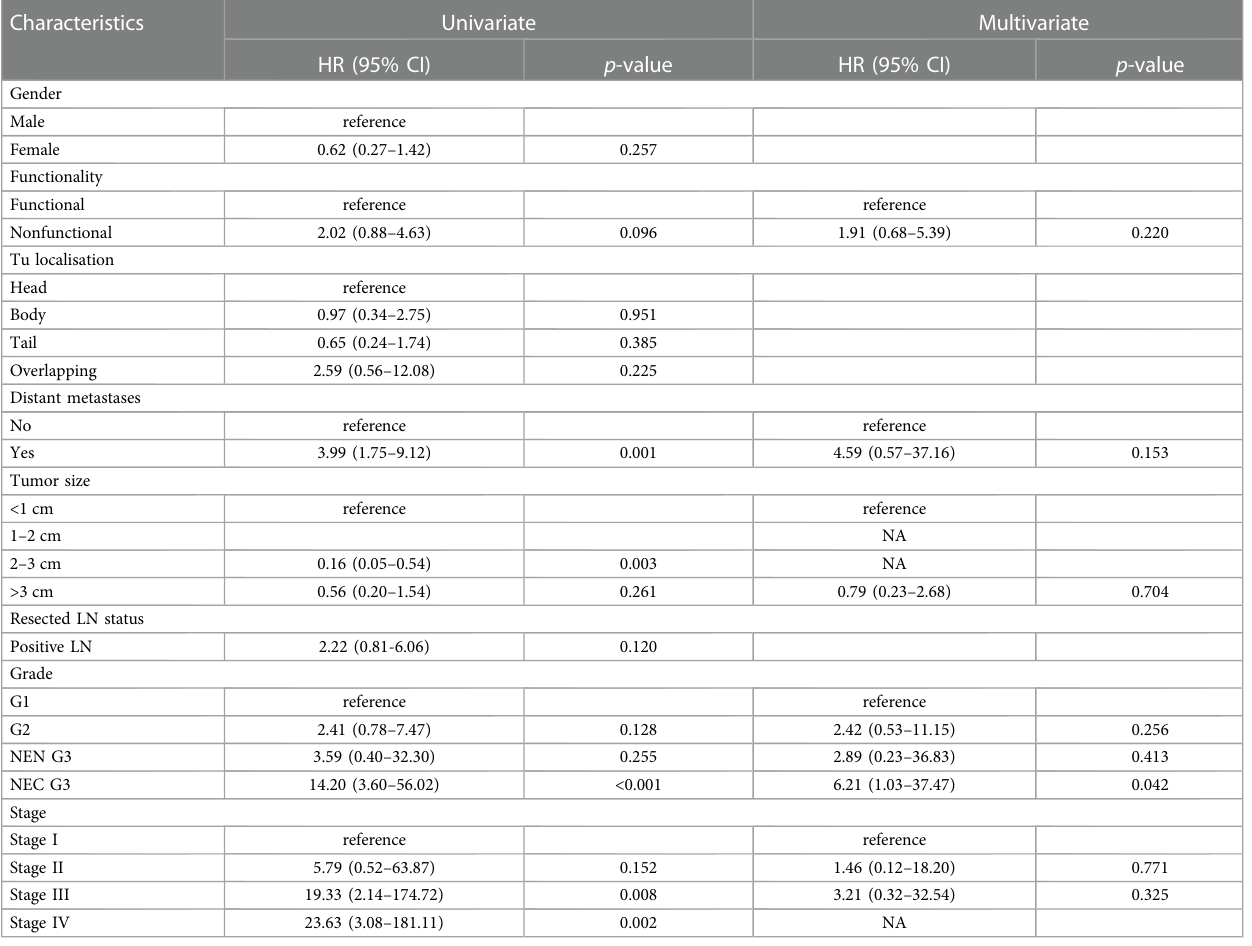
TABLE 5 Univariate and multivariable Cox proportional hazards regression model for OS.